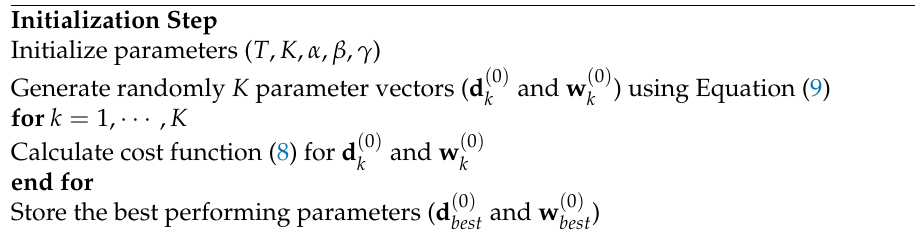
Algorithm 1 An algorithm for optimizing NUSLA using MORELA.